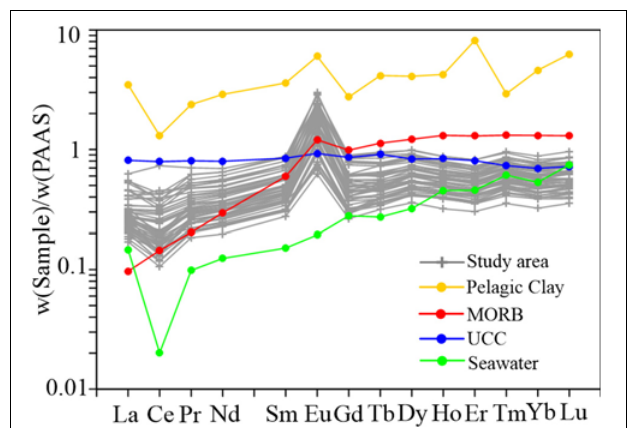
FIGURE 8 | Comparisons of PAAS-normalized rare earth elements patterns of surface sediments of the Emperor Seamount Chain, the content of REE of pelagic clay (Kato et al., 2011), MORB (Klein, 2003), UCC (Taylor and Mclennan, 1995), and seawater (Zhang and Nozaki,